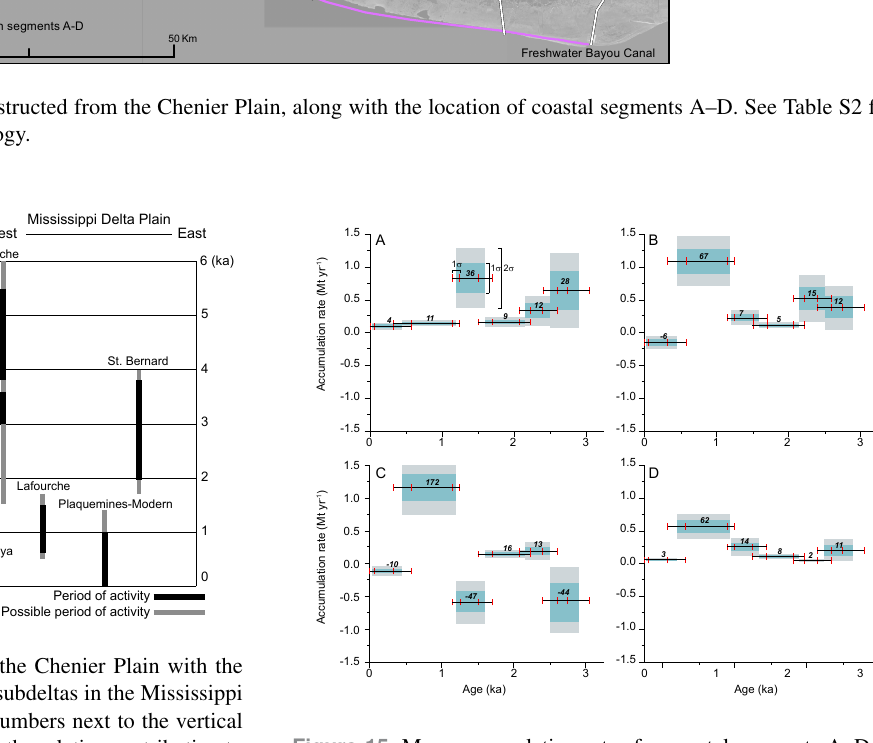
Figure 15. Mass accumulation rates for coastal segments A–D in the Chenier Plain (Fig. 13). Since the segments have different sizes, the relative contribution (in %, plotted above the horizontal error bar) of each time interval to the total accumulation was calculated to facilitate